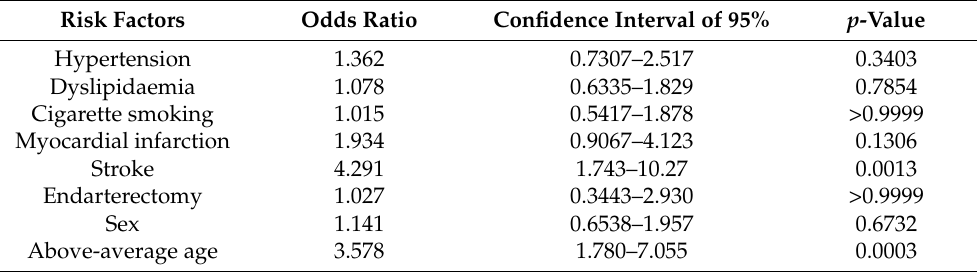
Table 6. Analysis of the correlations between the risk factors and worsening of stenosis in diabetic patients (worsened patients: 127; stable patients: 93; and total patients: 220). Risk Factors